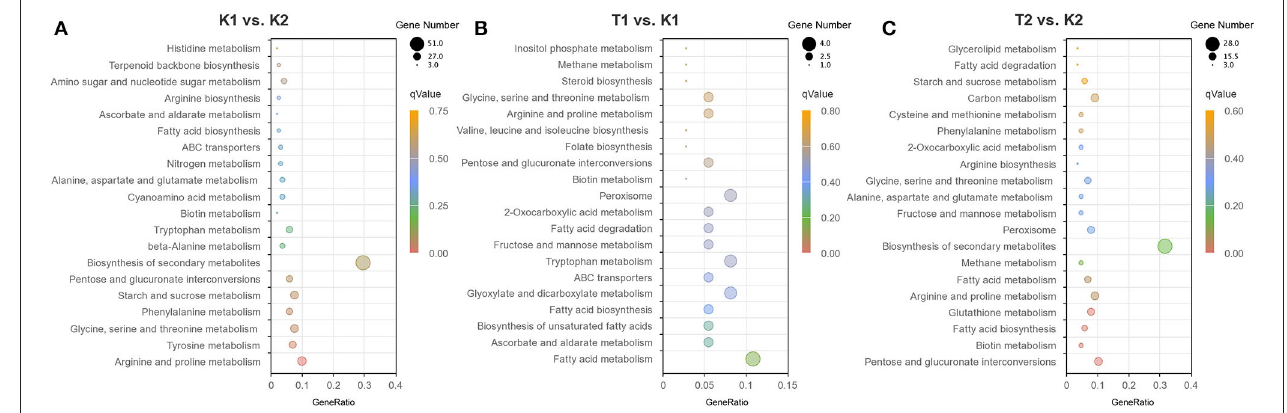
FIGURE 4 | Bubble chart of KEGG enrichment analysis DEGs in compared groups of (A) K1 vs. K2, (B) T1 vs. K1 and (C) T2 vs. K2. The most significant 20 pathway in the KEGG enrichment results from compared groups. The X-axis (GeneRatio) indicates the ratio of the number of genes annotated into that KEGG pathway and the total number in differential genes in that group. The q value indicates the significant difference of KEGG enrichment, indicated by different colors in the plots, and the size of the bubble indicates the number of genes in the pathway.